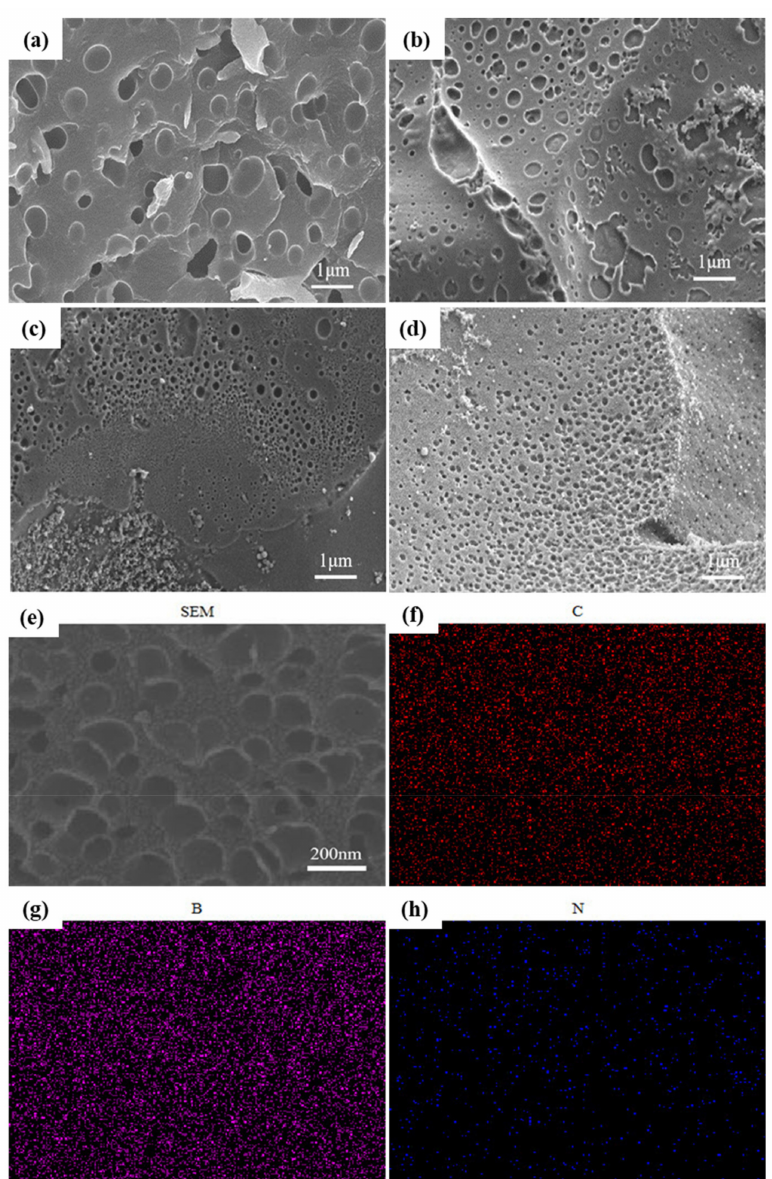
Figure 2. SEM images of the NPC ( a ), BNPC-0.05 ( b ), BNPC-0.10 ( c ) and BNPC-0.15 ( d and e ), and the elemental distribution of BNPC-0.15 probed by energy-dispersive spectroscopy (EDS) mapping ( f – h